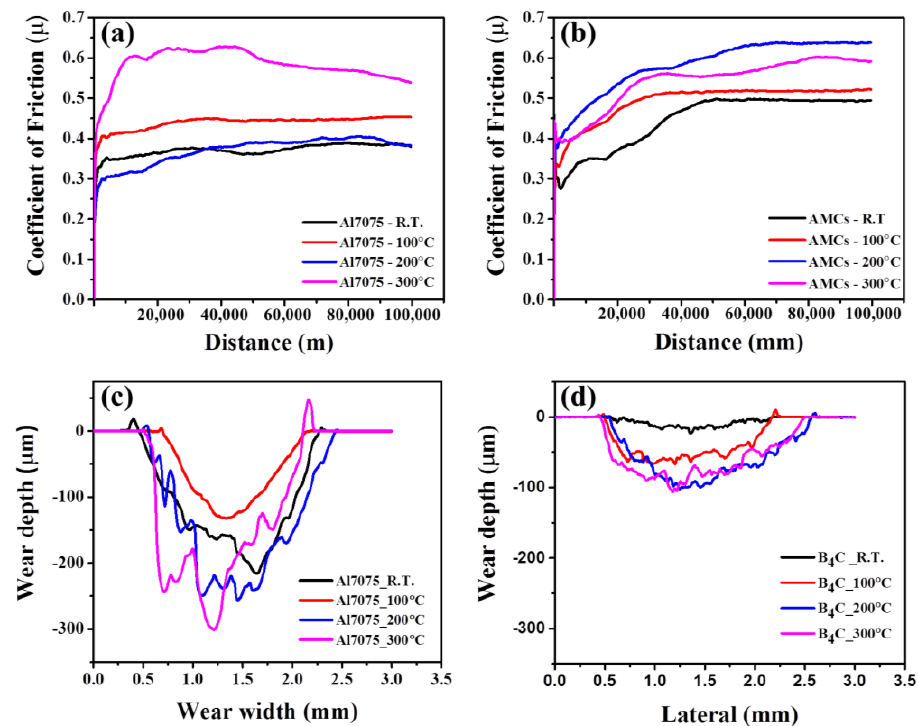
Figure 5. COF after the wear test ( a ) Al7075, ( b ) AMCs, depth and width of wear test, ( c ) Al7075, and ( d ) AMCs.